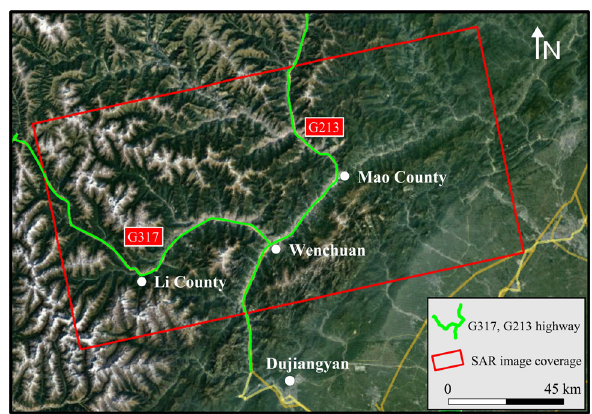
Figure 2. The location of G317, G213 near Wenchuan and the SAR image coverage